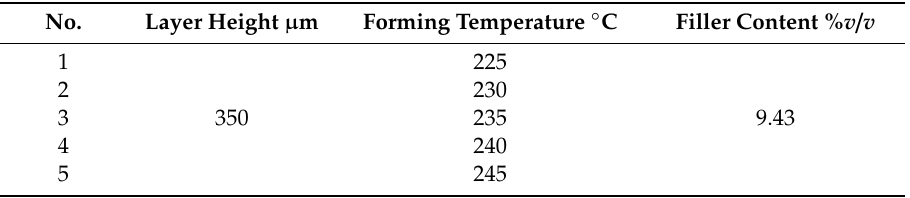
Table 1. Parameters of fibrous composites, 1st stage of research.